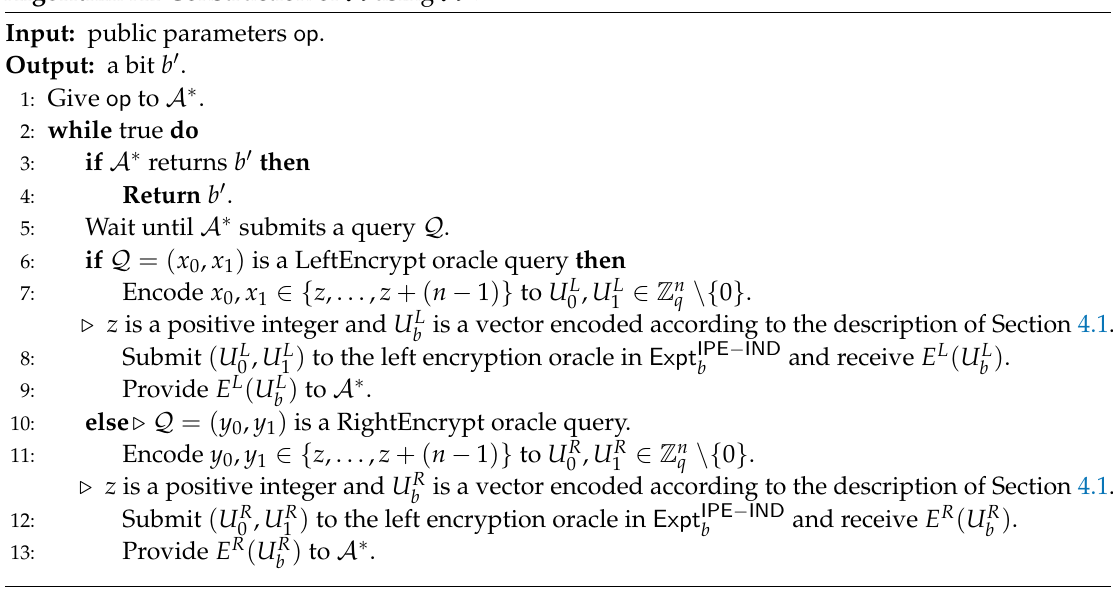
Algorithm A1 Construction of A using A ∗